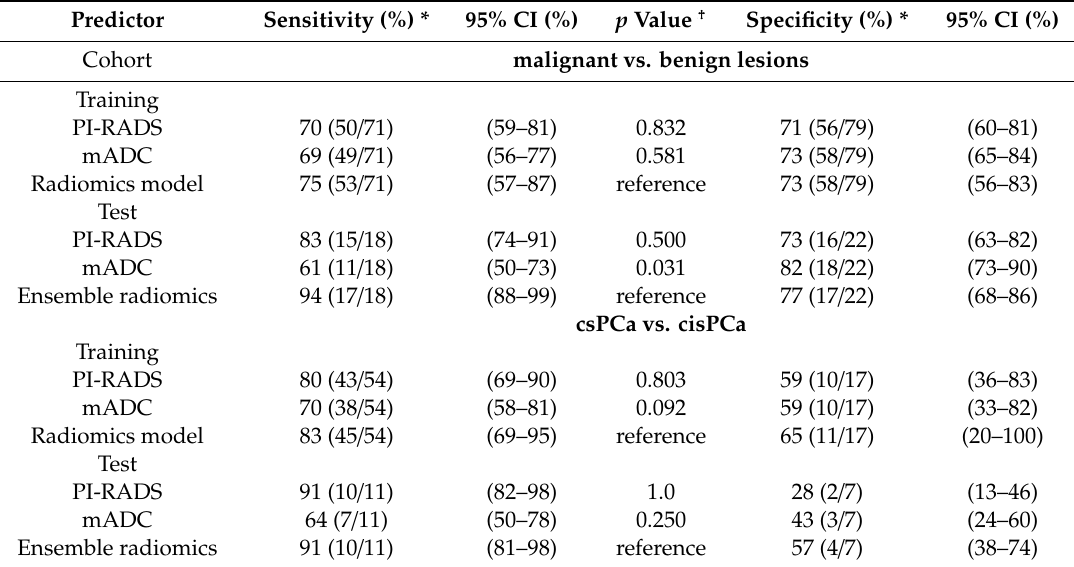
Table 2. Results of ROC analysis for the two selected classification tasks. Table 3. Diagnostic performance of radiologist interpretation and radiomics on a per patient basis.